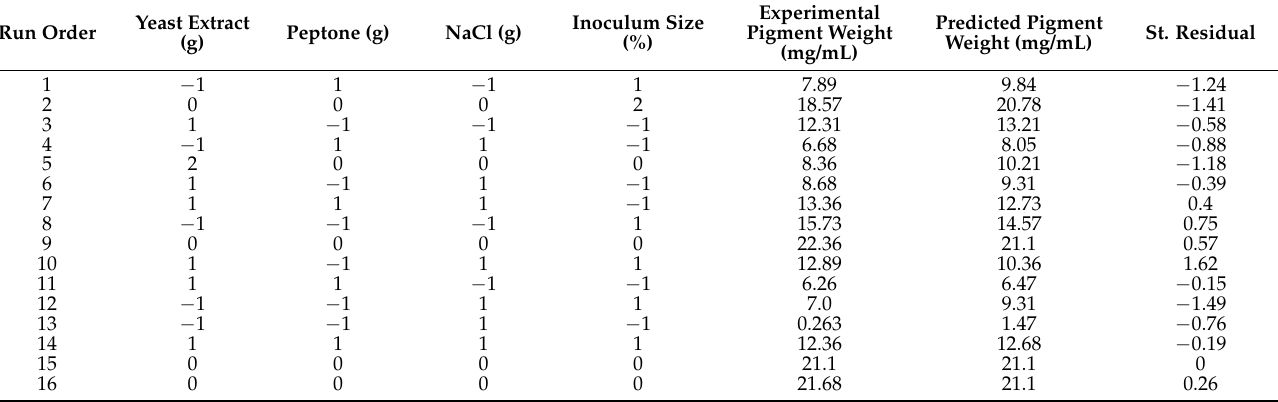
Table 3. Central composite design (CCD) representing matrix and pigment weight (mg/mL) extracted from V. halodenitrificans DASH as influenced by yeast extract, peptone, NaCl concentrations and inoculum size (%), along with the predicted pigment weight, residuals and concentrations of variables at each